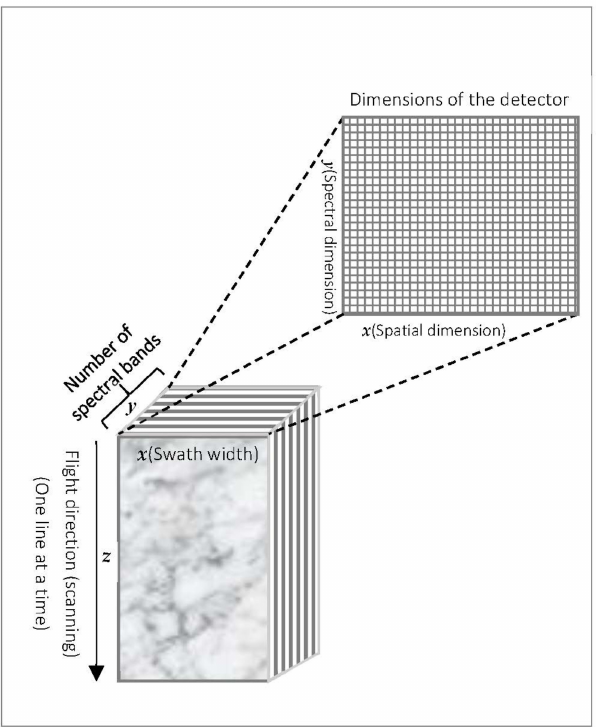
Figure 1. Conceptual view of the construction of hyperspectral images by a pushbroom scanner (not shown) during airborne